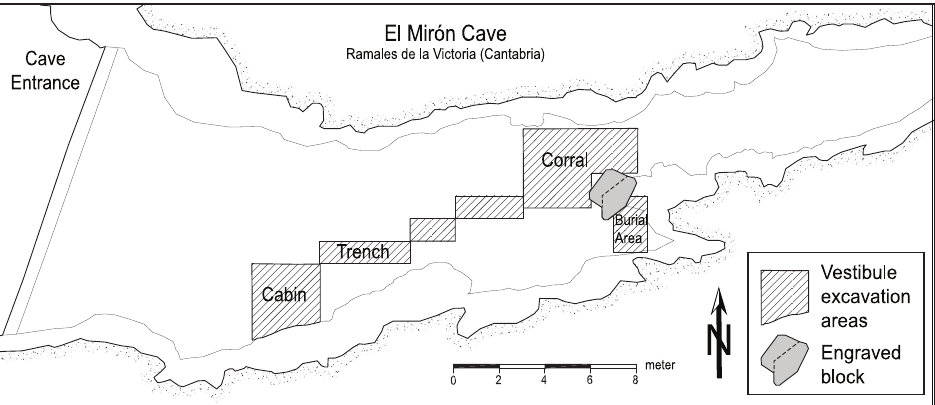
Figure 2: The two main excavation areas, Cabin and Corral, are connected with a trench and, behind the engraved block, a human burial was excavated. The material from this study originates from the Cabin area. Lower Cantabrian Magdalenian deposits were found in all other excavation areas (plan modified, original outlines made by GIM GEOMATICS